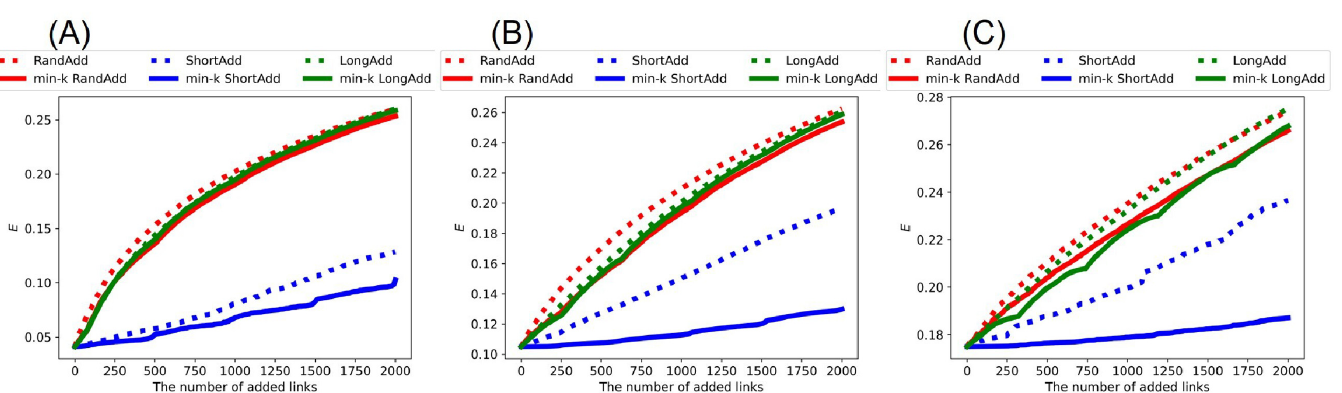
Fig 14. Network efficiency after adding links to random trees. The RandAdd method (red dotted line) is the most effective for increasing E among six methods. The min- k ShortAdd method (blue solid lines) is lower than the other five methods. The initial random tree has (A) narrower, (B) exponential, and (C) power-law degree distributions. The correspondence between lines and methods is the same as shown in Fig 2.